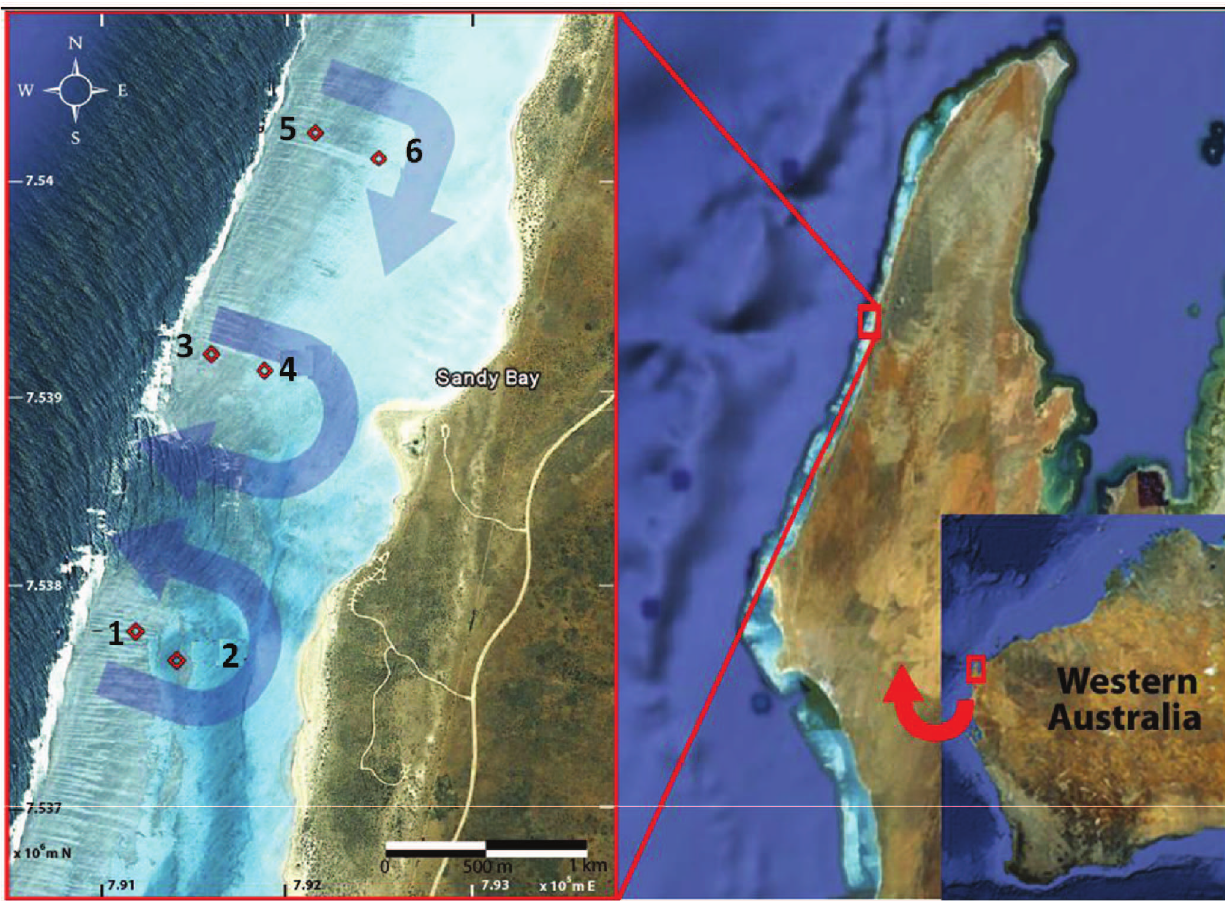
Figure 1. Map of the study region and sampling stations (depicted by red diamonds and numbers). Superimposed blue arrows show the characteristic flow pattern across the reef flat and around the lagoon [85]. Satellite imagery: Google Earth, 2010.